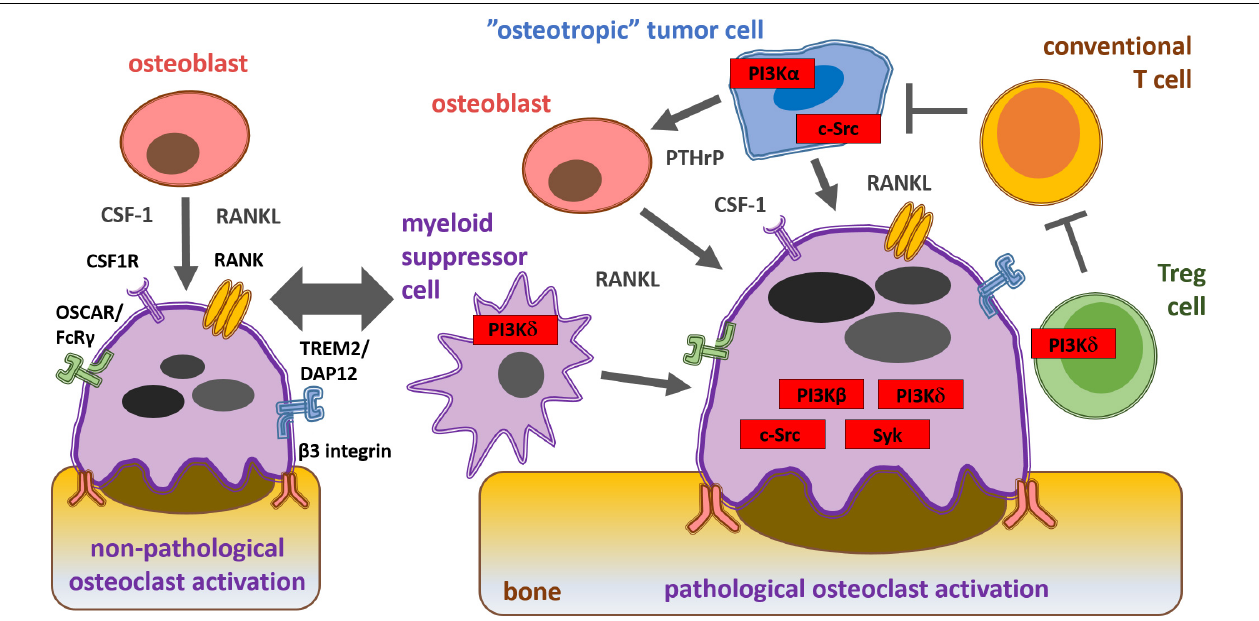
FIGURE 2 | Schematic representation of physiological and pathological osteoclast activation during bone metastasis formation and key signaling molecules within the solid tumor microenvironment from a therapeutic aspect. Osteoblast-derived cytokines and interactions with the bone matrix lead to physiological osteoclast activation via CSF1, RANK, costimulatory and β 3 integrin receptors. “Osteotropic” tumor cell recruited regulatory T cells (Tregs) and myeloid derived suppressor cells (MDSC) inhibit conventional T cells (Tconv) and promote cancer cell-induced pathological osteoclast activation via PI3K β , PI3K δ , c-Src, and Syk.